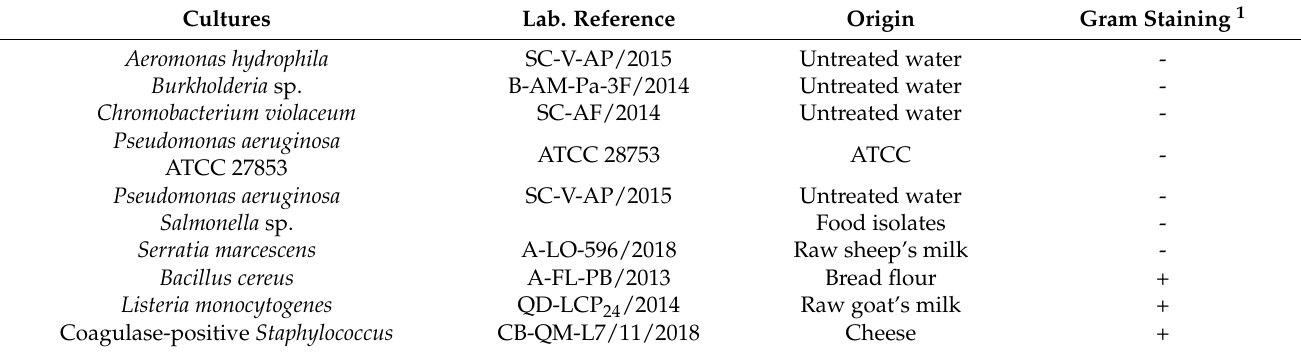
Table 1. Identification and characterization of bacterial